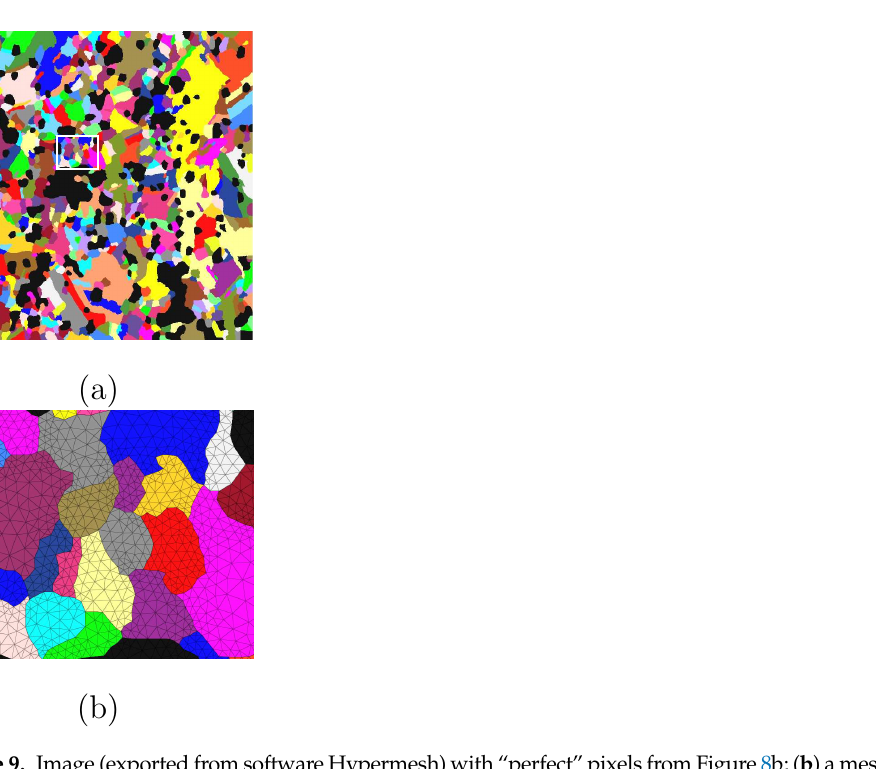
particles (from 2